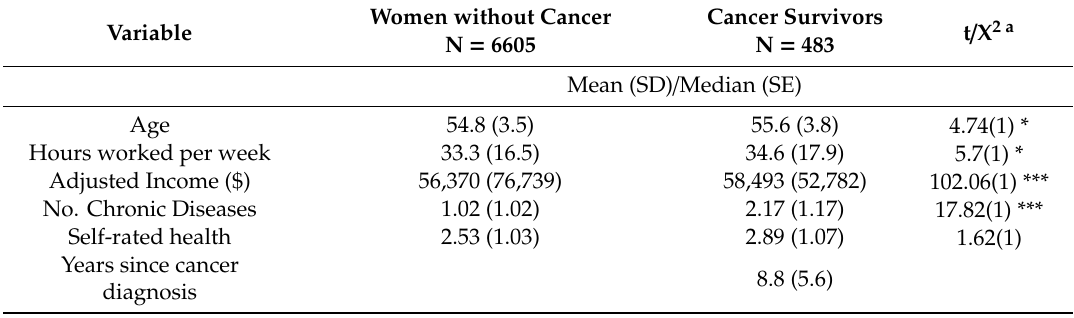
Table 1. Baseline Characteristics of the Study Sample, Health and Retirement Study, 1998–2014 ( n =